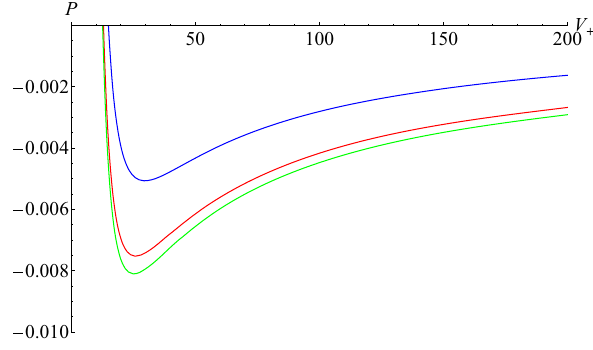
Fig. 8 We plot the free energy F + as a function of the black hole tem- perature T + , under the different values of the thermodynamic pressure P , at the magnetic charge Q = 1. The blue, red, green, and purple curves correspond to P = − 0 . 005, − 0 . 001, − 0 . 0005, − 0 . 0001